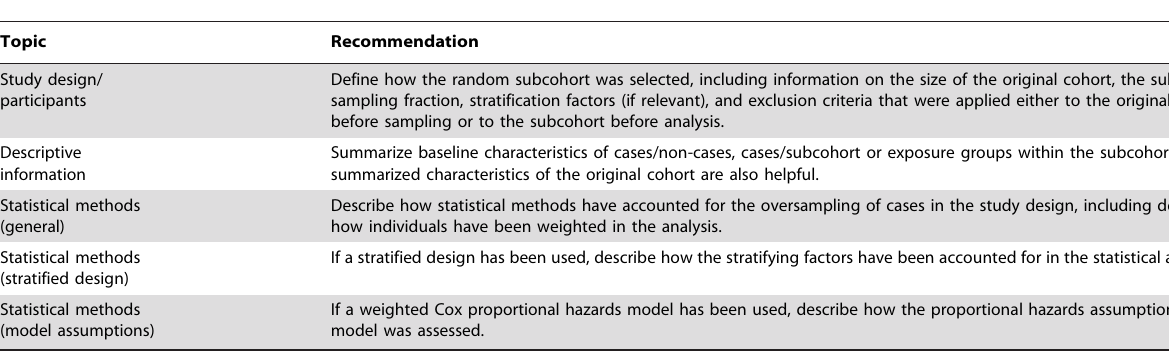
Table 3. Summary of recommendations for reporting case-cohort studies, to be used alongside existing STROBE guidelines.